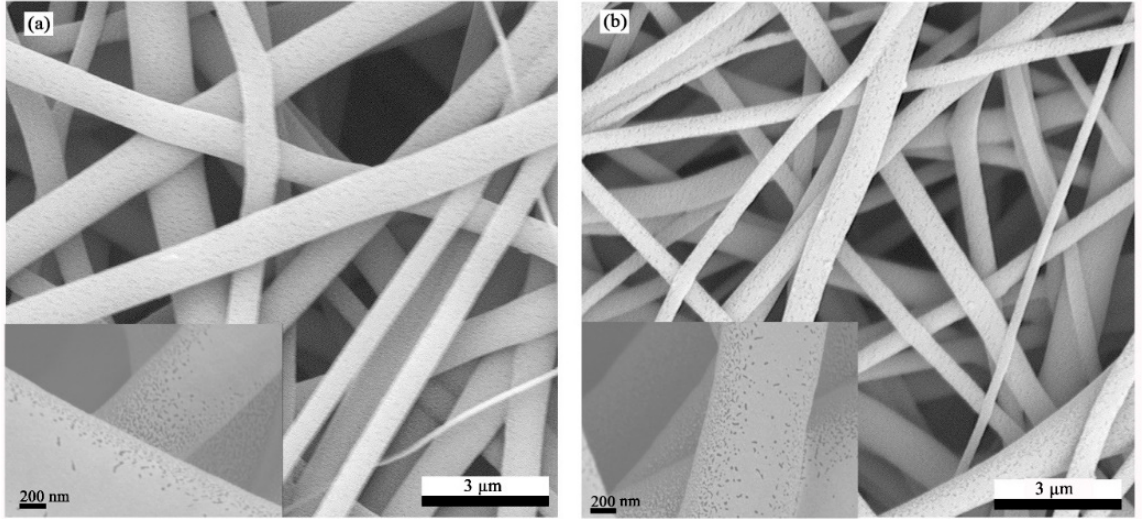
Figure 4. SEM micrographs of the electrospun fiber surface: ( a ) 14% concentration and ( b ) 16% con ‐ Figure 4. SEMmicrographsoftheelectrospunfibersurface: ( a )14%concentrationand( b centration.